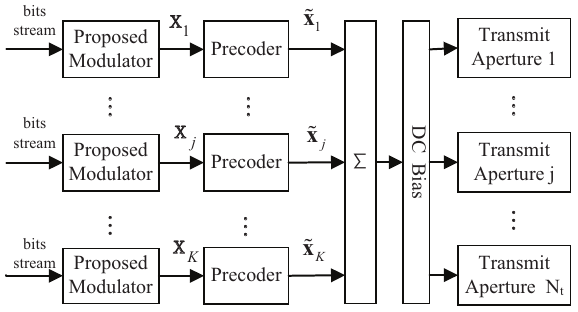
Figure 1. Transmitter structure for